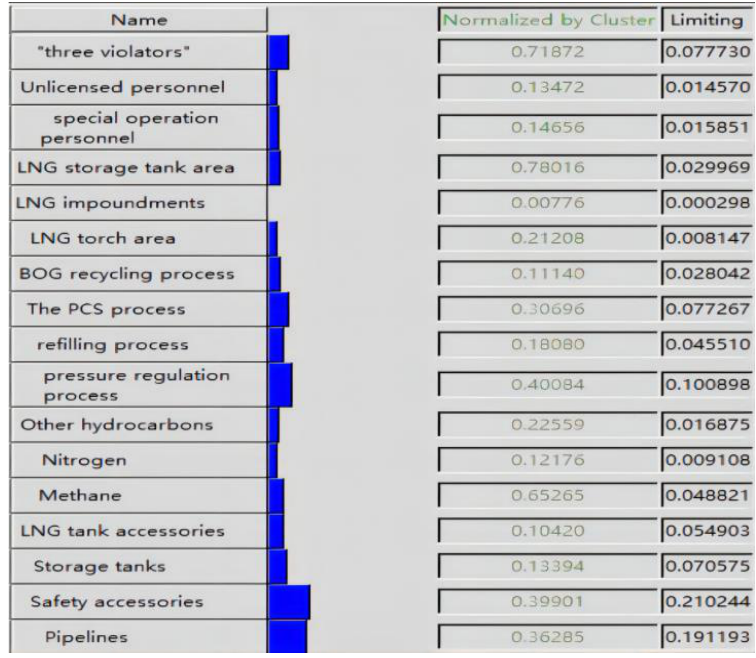
Figure 6. Priority of secondary